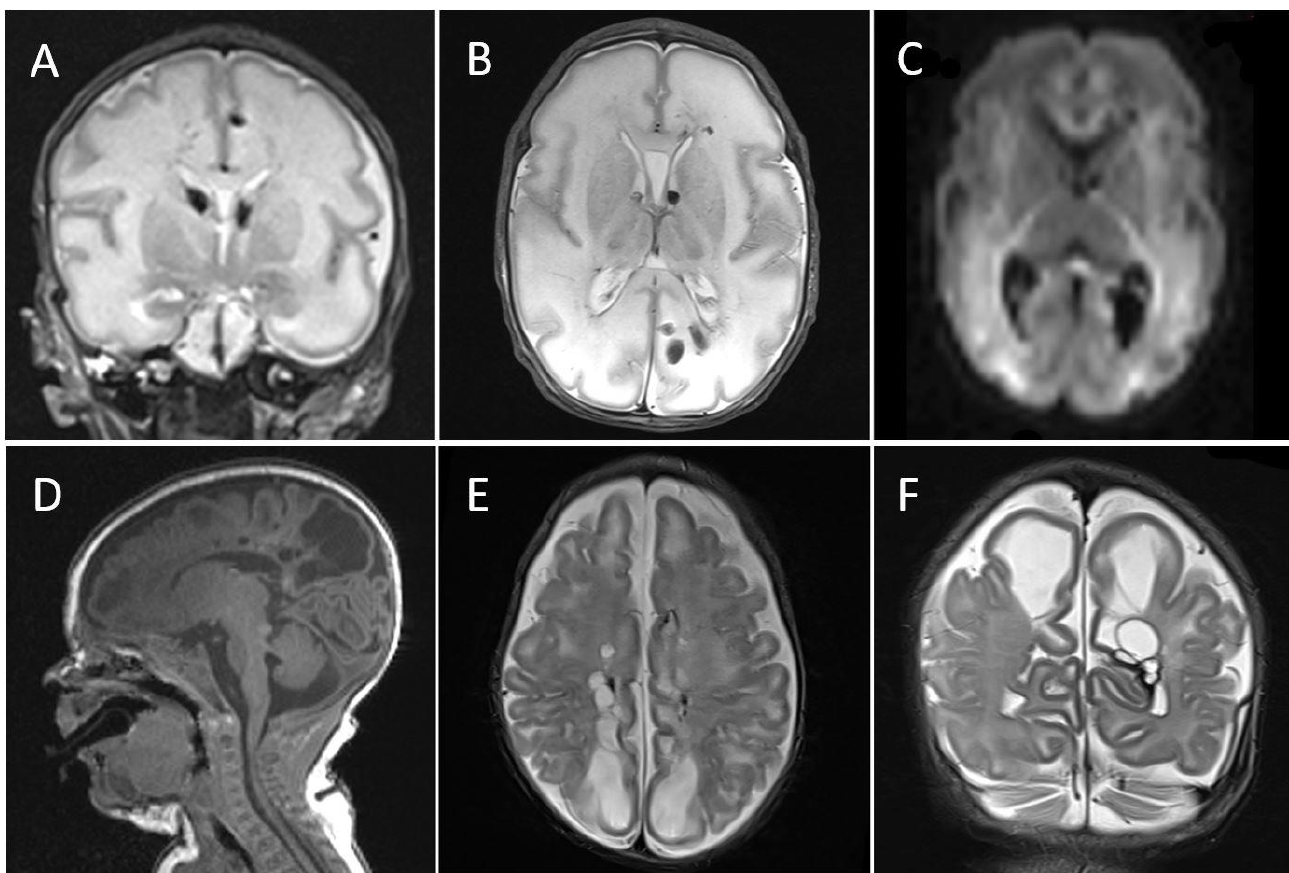
Figure 3. CASE 2: Postnatal brain imaging of the neonates. Postnatal day 7 MRI with ( A ) coronal, ( B ) axial T2-weighted, and ( C ) axial diffusion-weighted images showing germinal, intraventricular, and multiple parenchymal hemorrhages, as well as severe anoxic lesions affecting the white matter bilaterally predominantly in parieto-occipital regions and the basal ganglia. ( D ) Postnatal day 55 (40 weeks postmenstrual age) MRI with sagittal T1-weighted, ( E ) axial, ( F ) and coronal T2-weighted images showing transformation of the anoxic lesions to bilateral cystic periventricular leukomalacia, predominantly in parieto-occipital lobes and sequelae of germinal matrix and fronto-parietal white matter hemorrhage.